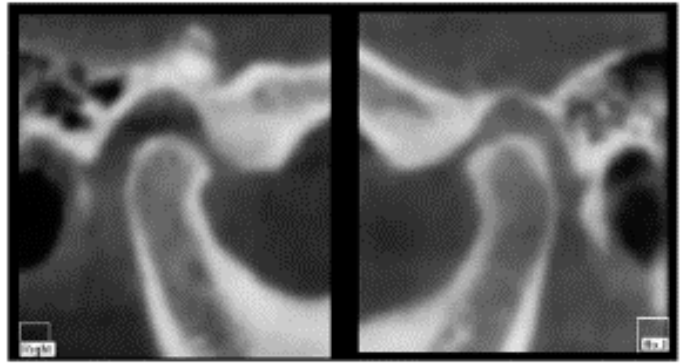
observed (Figure 4).